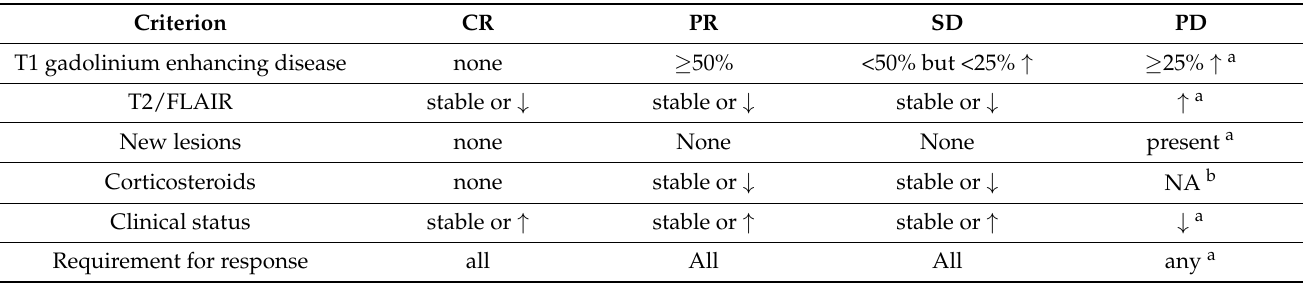
Table 1. Summary of the RANO Response